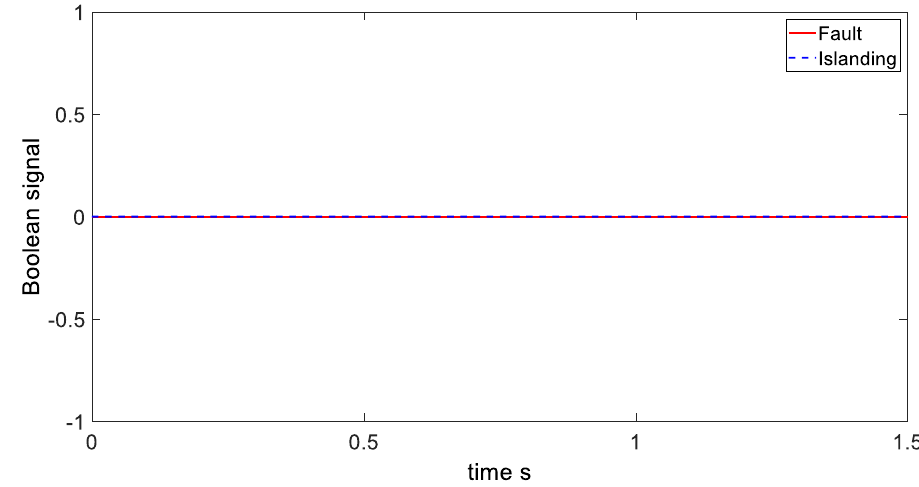
Figure 15. Boolean signal of islanding and fault detection for case 5.